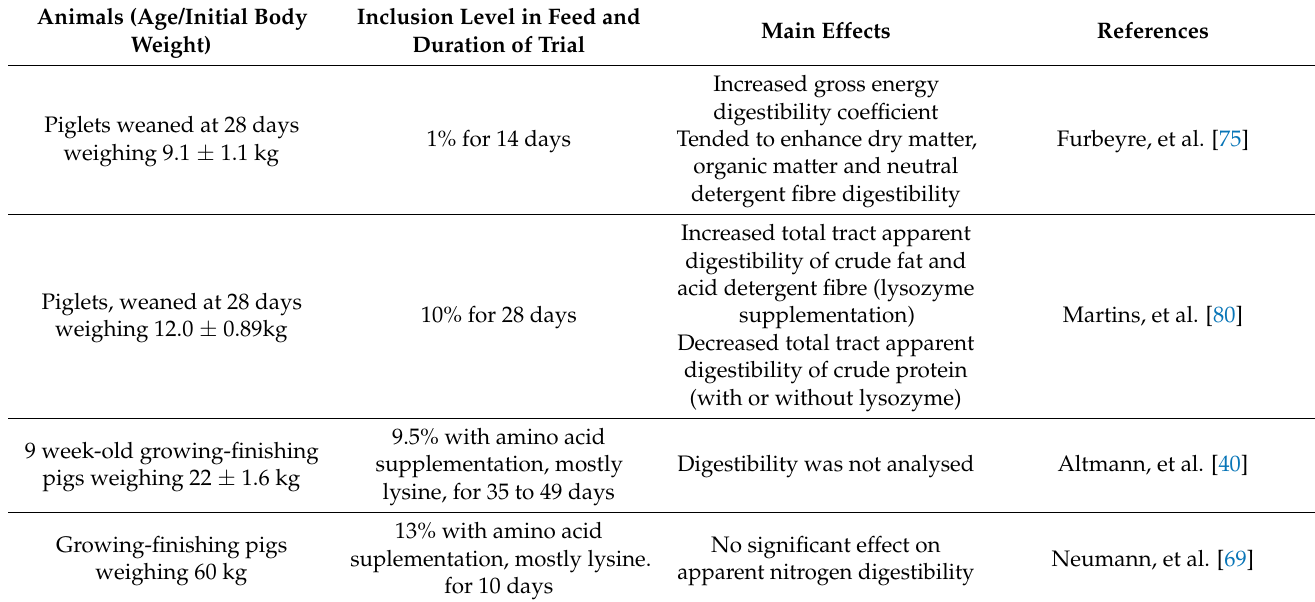
Table 5. Summary of main effects on nutrient digestibility of dietary inclusion of A. platensis in in vivo trials on